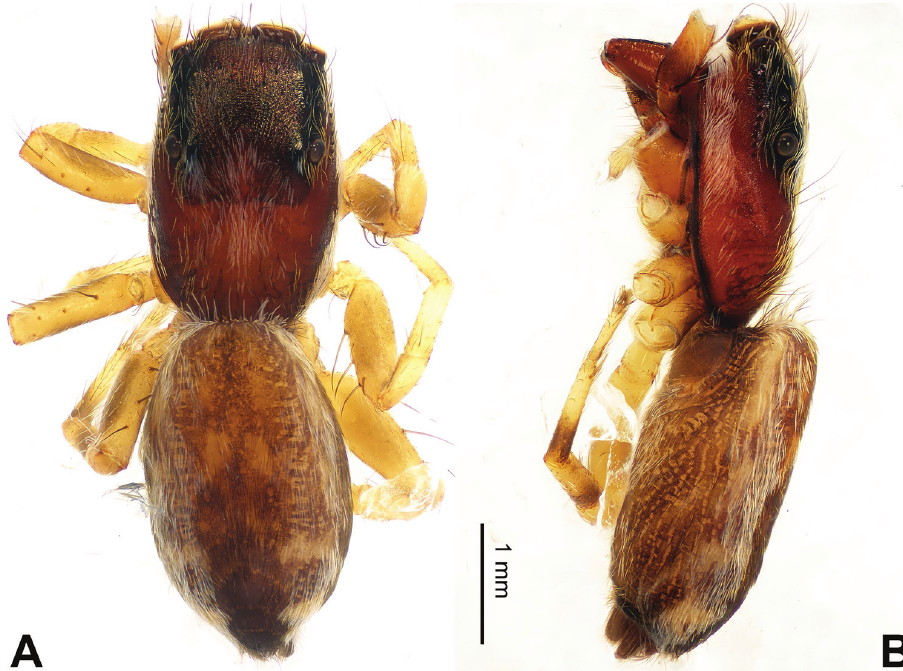
Figure 2. Habitus of Afraflacilla ballarini sp. n., male holotype. A dorsal B lateral.